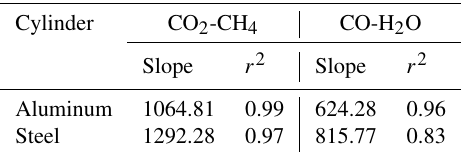
Table 2. Reduced major axis regression slopes and the coefficients of determination among species for temperature